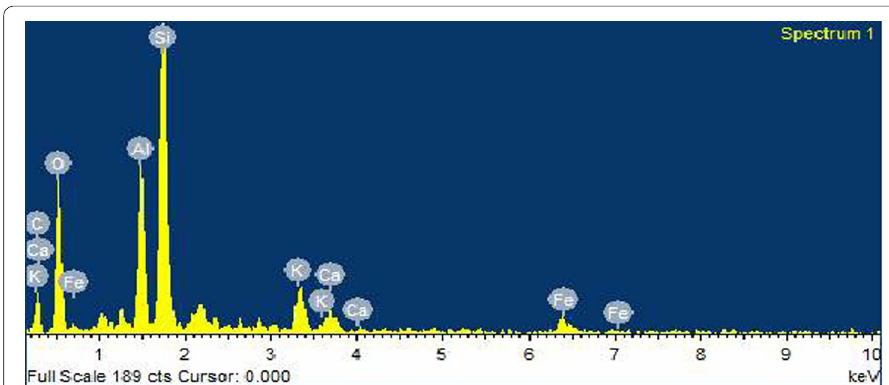
Fig. 11 Energy dispersive X-ray (EDX) graphs of KTPS bottom ash